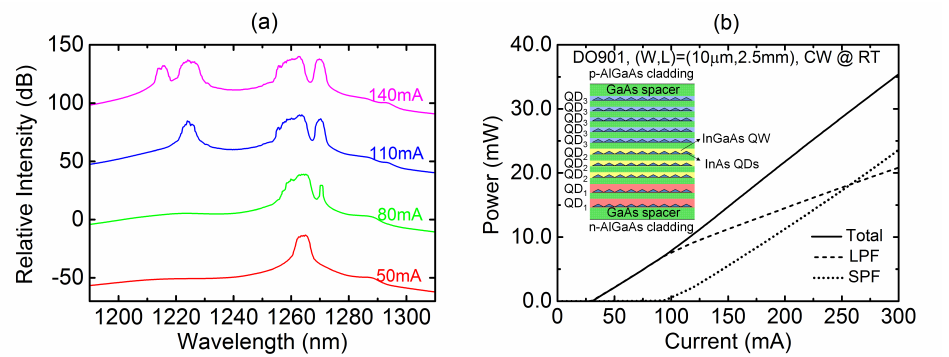
Figure 1. ( a ) the evolution of lasing spectra with injection current; ( b ) light-current (L-I) curves with optical long-pass filter (LPF), short-pass filter (SPF), and without optical